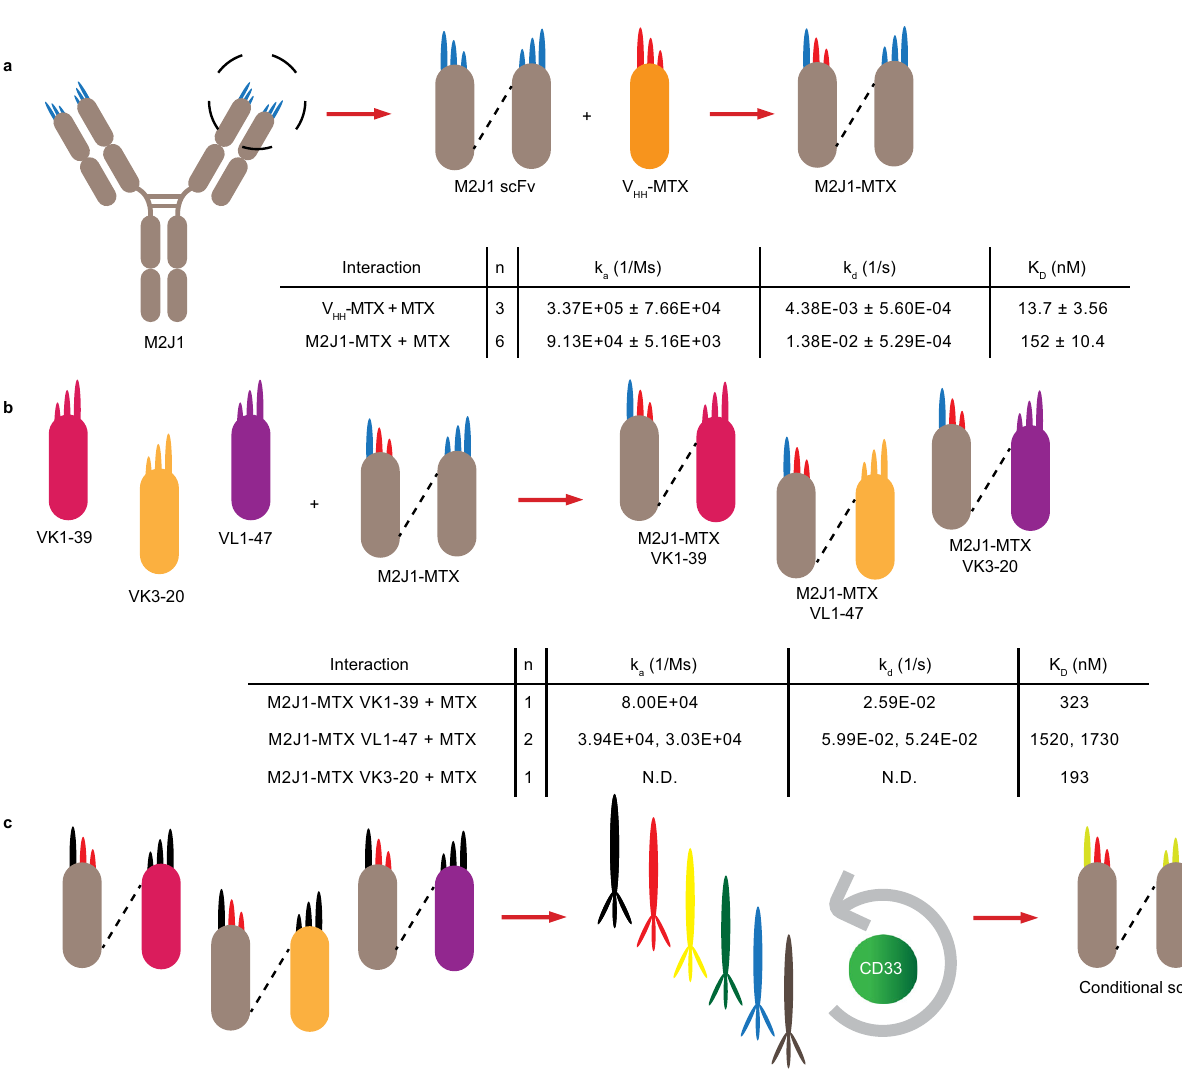
Fig. 1 Design of conditional scFv and screening. a CDRH1 (in red), CDRH2 (in red) and FW3 from V HH -MTX were grafted onto the V H of scFv derived from M2J1 antibody (M2J1 scFv) to form a humanized M2J1-MTX scaffold (M2J1 CDRs in blue). b V H of M2J1-MTX can be paired with different germline V L ’ s and maintain binding to MTX. N.D. is not determined. c A conditional scFv library was generated by fi xing CDRH1 and CDRH2 and diversifying the amino acid sequences of CDRH3 and all three light-chain CDRs. This library was screened using phage display to isolate clones that bound CD33 in an MTX-dependent